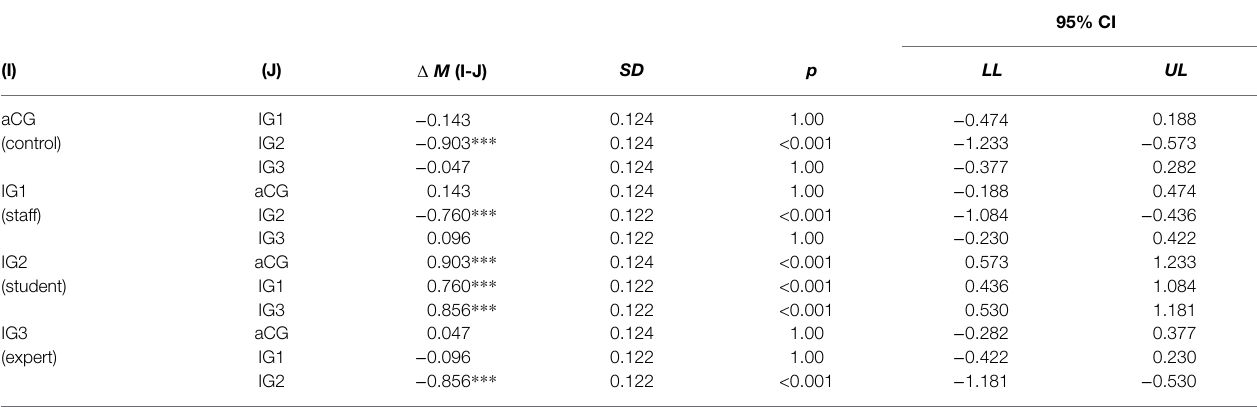
TABLE 2 | Differences between the experimental groups in intentions to use digital mental health interventions at post-intervention after adjusting for baseline intentions (multiple